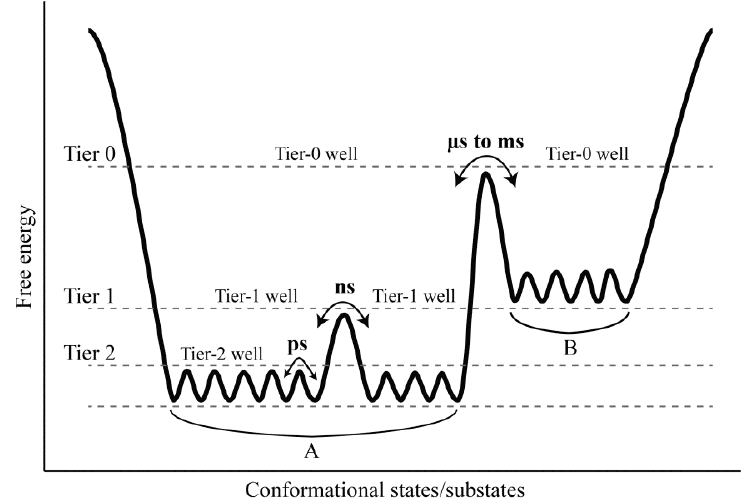
Figure 7. A proposed FEL model to explain the effect of the solvent mobility on protein dynamics. This model is represented as a hierarchical organization of free energy wells ( i.e. , the smallest tier-2 wells are within the relatively large tier-1 wells, and the tier-1 wells are within the largest tier-0 wells), which dictates the hierarchical dynamics of the protein ( i.e. , different structural components feature different amplitude and timescale of the fluctuations). The tier-2 and tier-1 substates and tier-0 states ( A and B ) are located within respective free energy wells. The tier-2, tier-1, and tier-0 dynamics, which are defined as conformational interconversion between respective substates/states, involve the side chain rotations on ps timescale, loop motions on ns timescale, and collective motions of the entire structure on timescale of μ s to ms, respectively. The tire-0 dynamics are a result of the accumulation of the tier-1 and tier-2 dynamics. By exacerbating the competitive interactions between the protein and solvent and between atoms within the protein, the solvent mobility plays its role in facilitating the cascade amplification of microscopic motions of atoms and atomic groups into the global collective motions of the protein (for details, see the text).